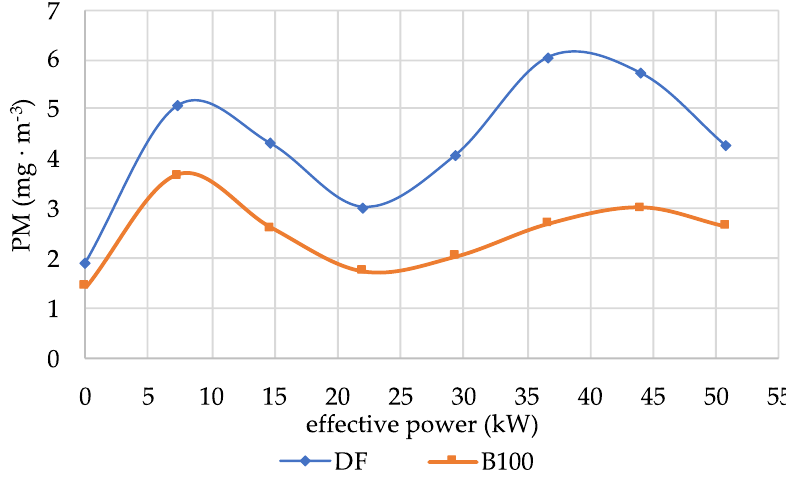
Figure 6. PM emissions vs. effective power of the John Deere 4045TF285JD engine at 1400 rpm.